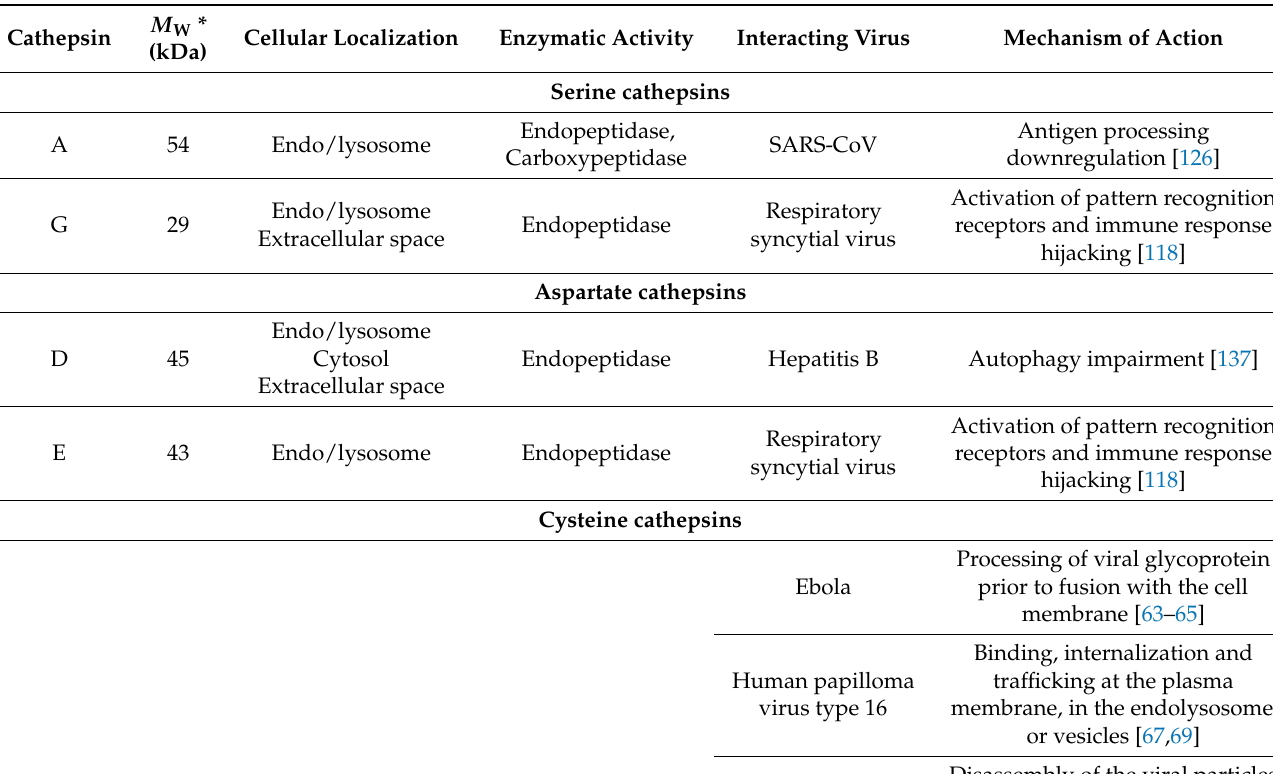
Table 1. Cathepsins Involved in Human Viral Infections and Their Mechanism of